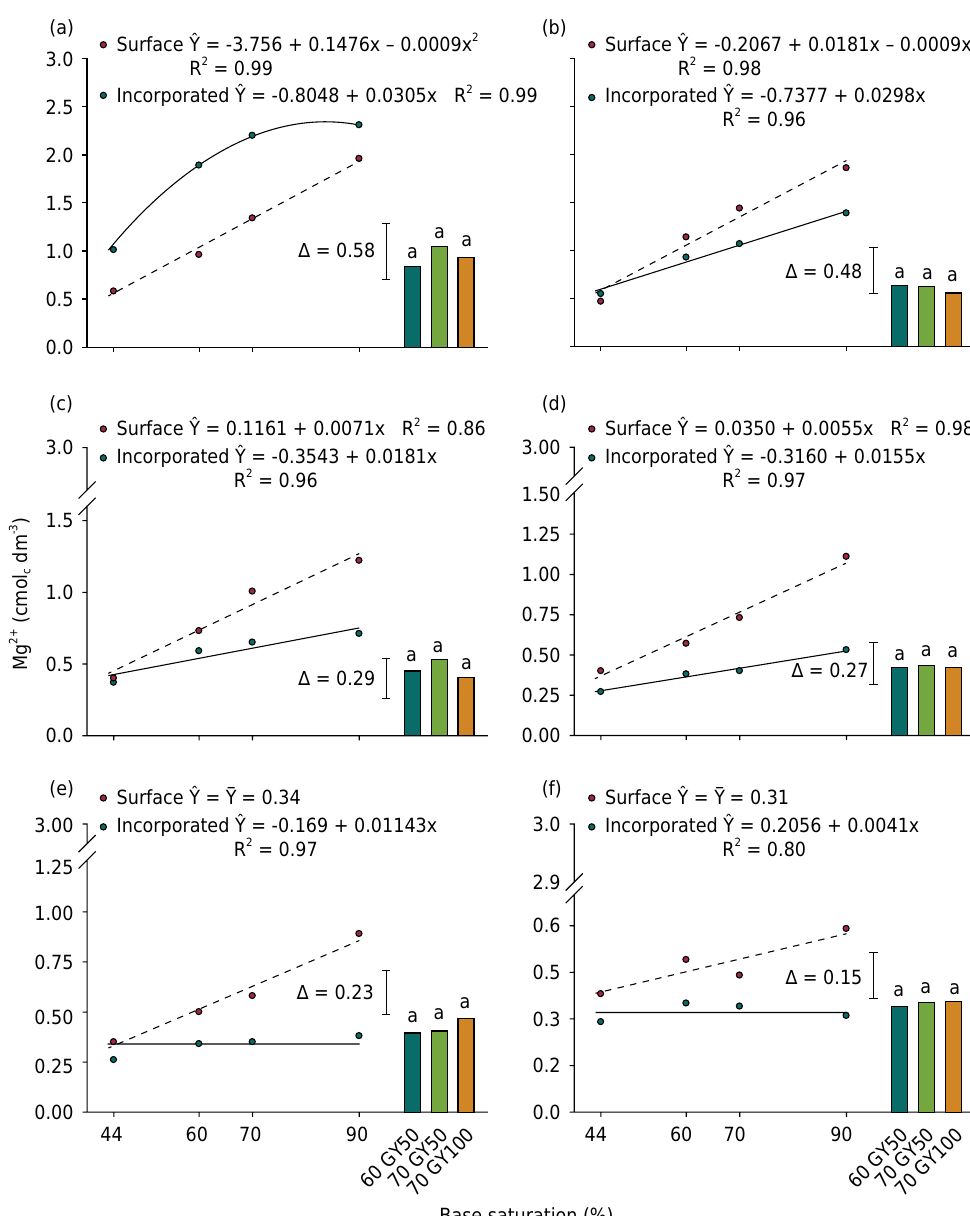
Figure 5. Magnesium (Mg 2+ ) content after reapplication of lime and phosphogypsum at different layers (m): 0.00-0.05 (a), 0.05-0.10 (b), 0.10-0.20 (c), 0.20-0.30 (d), 0.30-0.40 (e), and 0.40-0.60 (f). Different letters above the bars indicate a significant difference between the treatments with phosphogypsum based on Tukey’s test (p<0.05). The vertical bar indicates the DMS between each factorial vs additional treatment based on a Dunnett test (p<0.05). An F test revealed a significant difference between the modes of lime application to the layers presented in figures 1a (p<0.00), 1b (p<0.03), 1c (p<0.00), 1d (p<0.01), 1e (p<0.00), and 1f